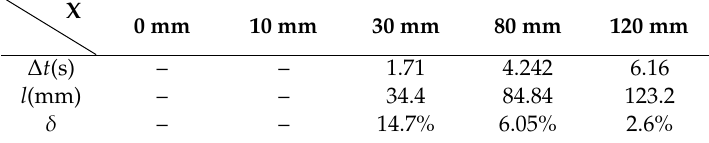
Table 2. Analysis table for positioning errors of the H13 and PMMA.